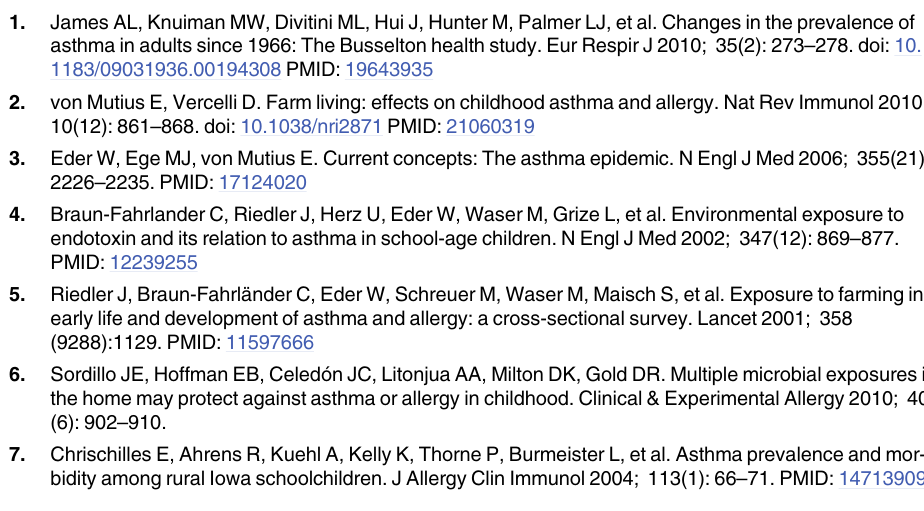
S1 Table. List of the questions about health outcomes and environmental factors and clini- cal data (for atopy definition) analysed against DGGE bands. S2 Table. QPCR assays applied on mattress dust samples in this study: target group, oligo- nucleotide sequence, optimized run parameters and reference to the original publications of the assays. S3 Table. Levels of microbes detected using qPCR (cells/m 2 dust) in the three exposure strata stratified by health